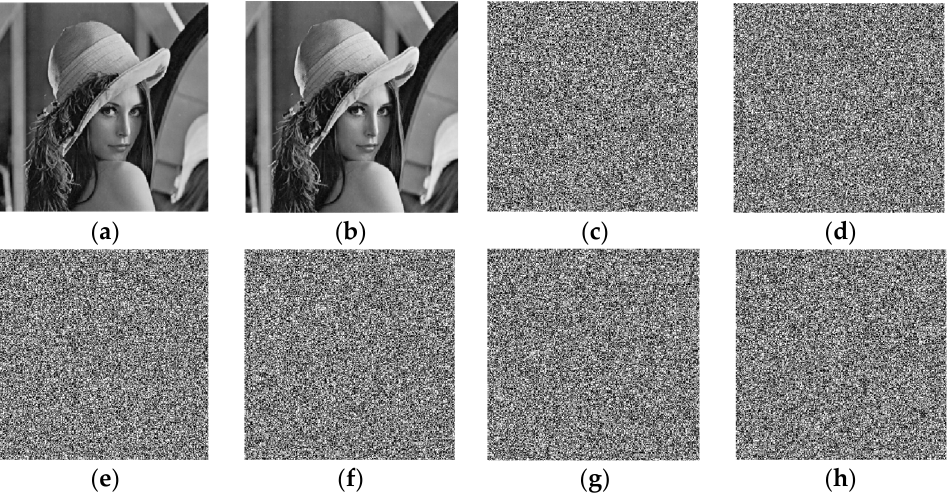
Figure 7. Key sensitivity analysis. ( a ) Plain Lena; ( b ) Decrypted image; ( c ) x 0 changes to x 0 + 10 − 14 ; ( d ) y 0 changes to y 0 + 10 − 14 ; ( e ) μ 1 changes to μ 1 + 10 − 14 ; ( f ) μ 2 changes to μ 2 + 10 − 14 ; ( g ) λ 1 changes to λ 1 + 10 − 14 ; ( h ) λ 2 changes to λ 2 + 10 − 14 .